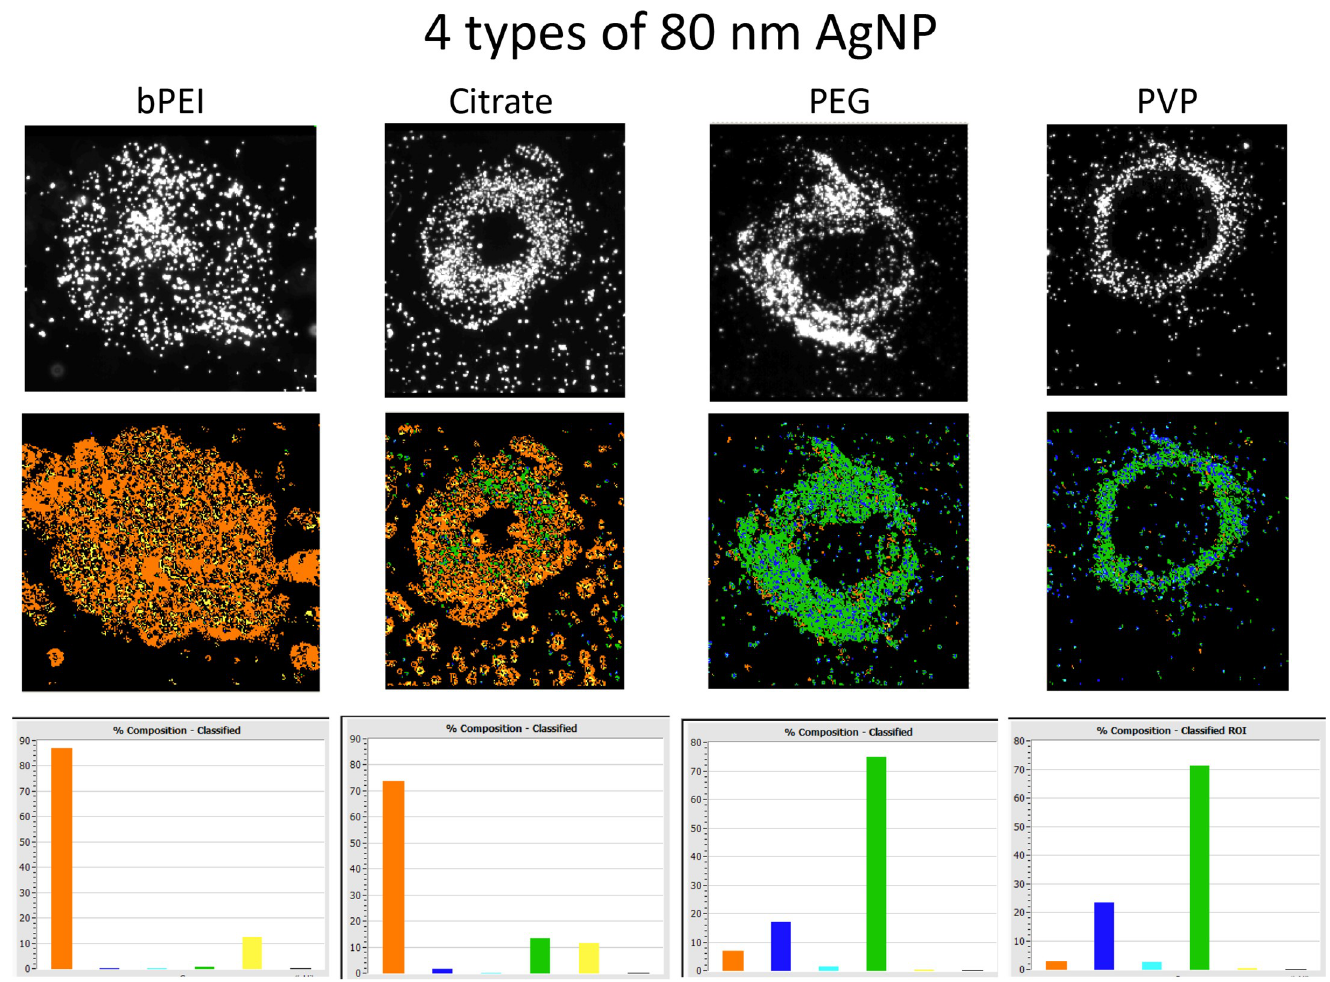
Fig 10. Hyperspectral image comparison of 4 types of AgNP. The top row in Fig 10 consists of scattered images from the PARISS hyperspectral system, while the middle row presents pseudo-colored images using the spectral library shown in Fig 9A. The percentage of each type of spectra is shown in the histograms displayed on the bottom row of Fig 10. The magnification of the images was